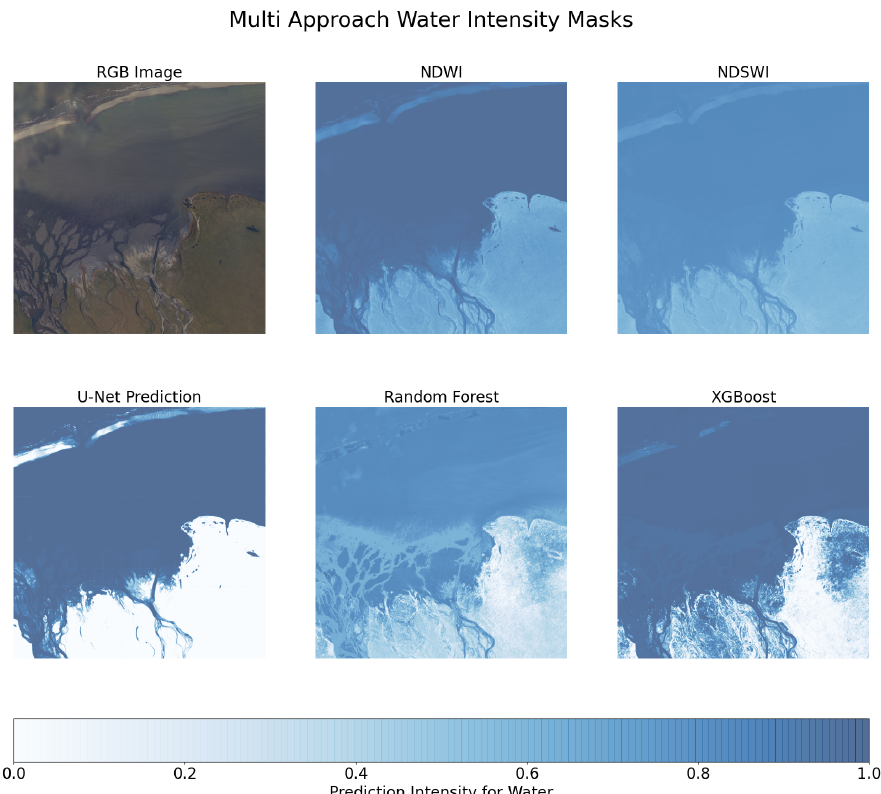
Figure 6. Output intensity on a sample image from the test set using different models. The intensity has been normalized to 0–1 range for NDWI and NDSWI for plotting. The intensity for U-Net, Random Forest, and XGBoost represents the probability of the corresponding pixel to be classified as